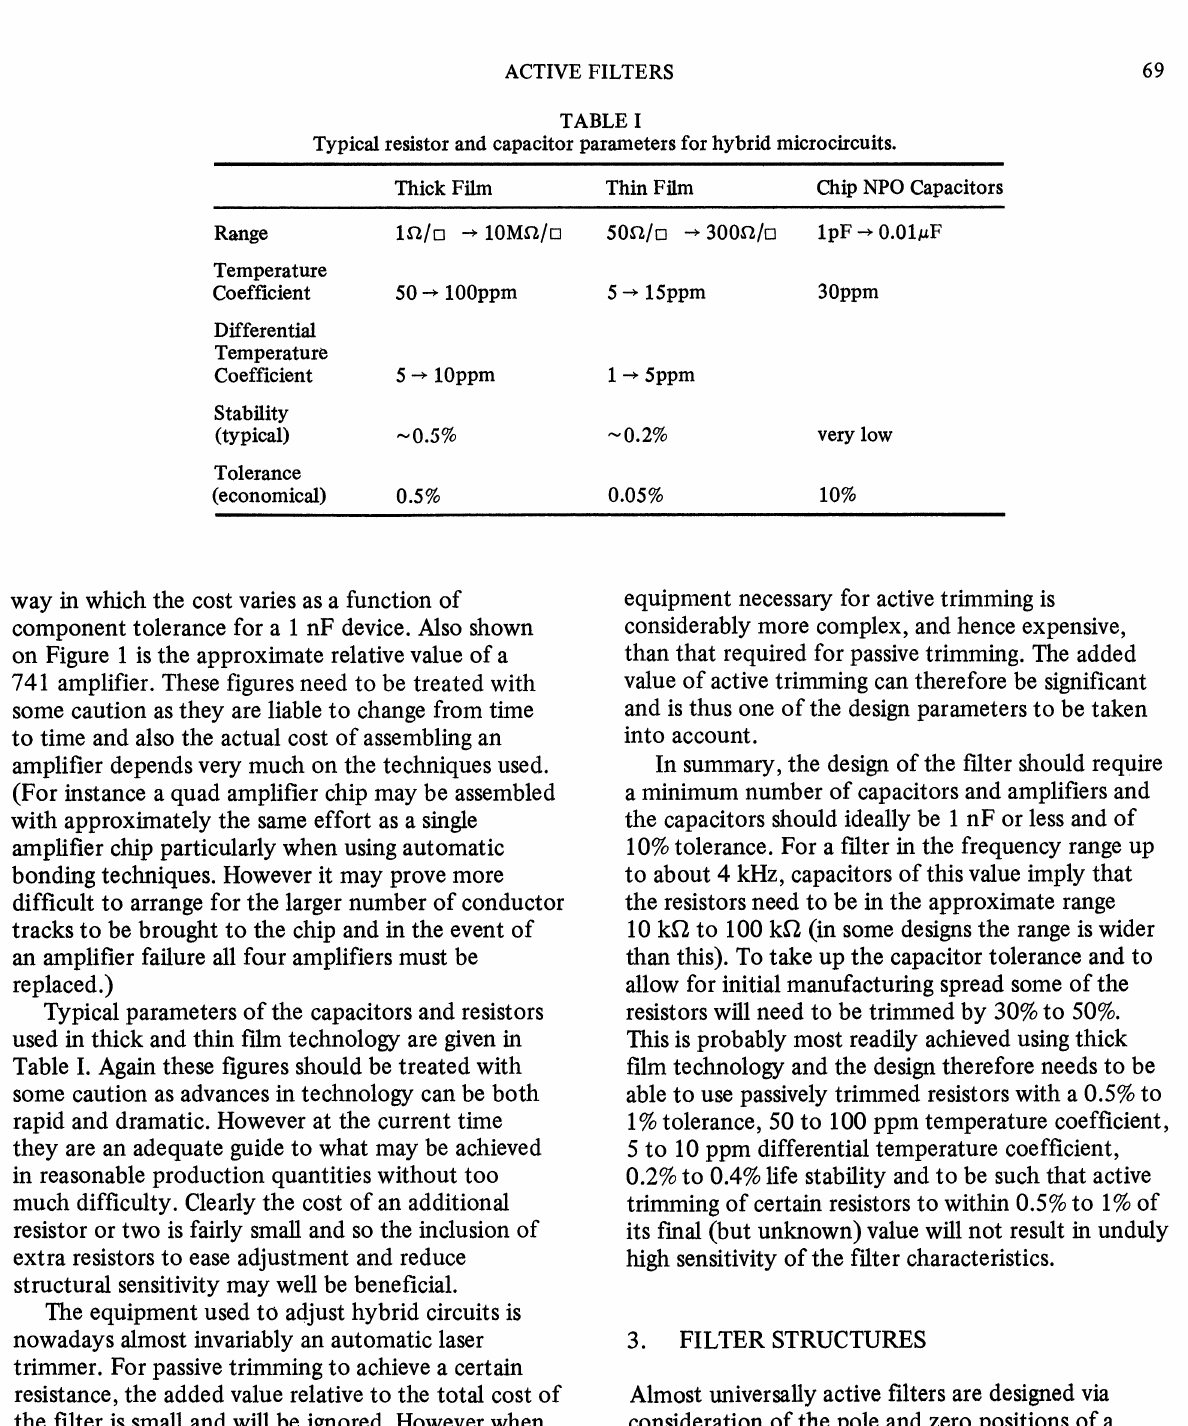
TABLE Typical resistor and capacitor parameters for hybrid